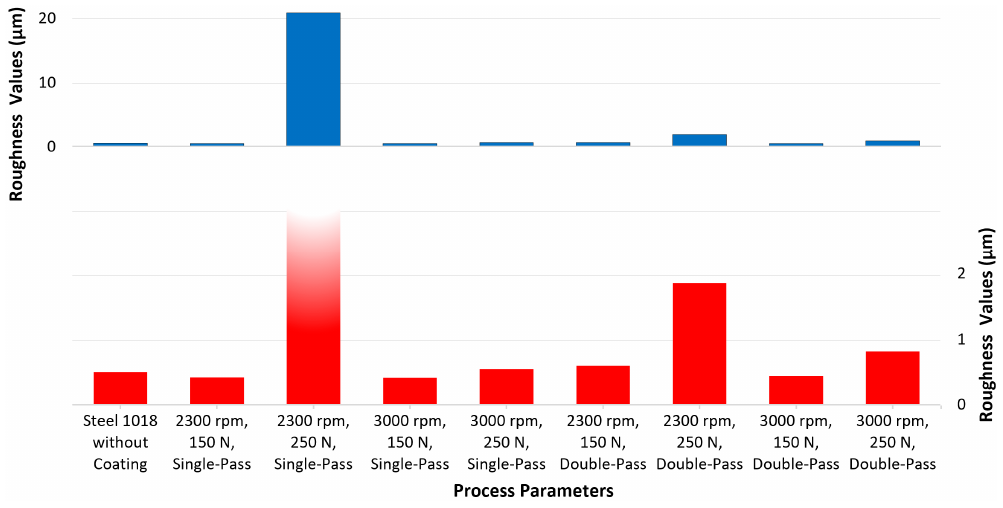
Figure 9. Influence of process parameters on the surface roughness ( Ra ) of the coatings.